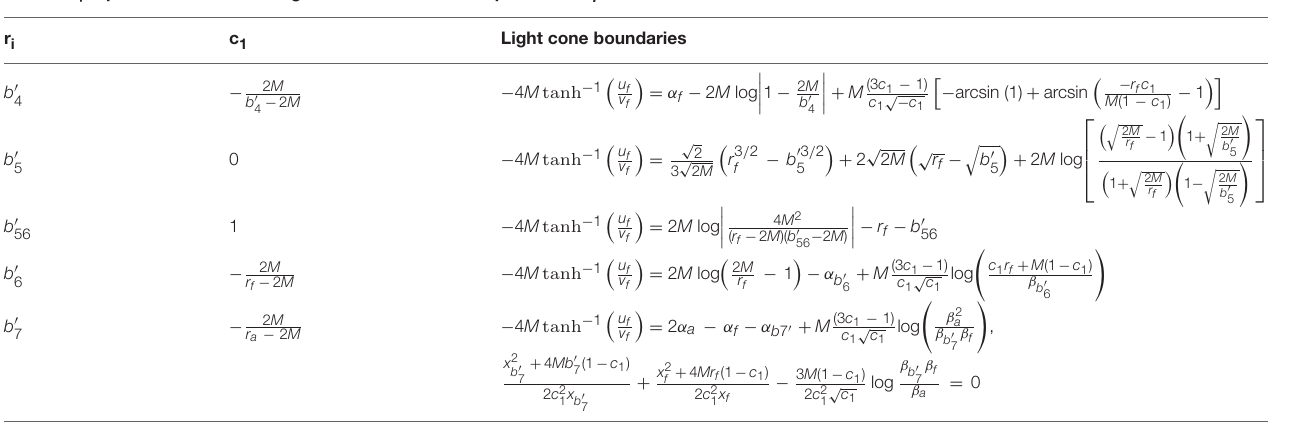
TABLE 4 | Equations of motion at light cone boundaries for paths with r f < 2 M